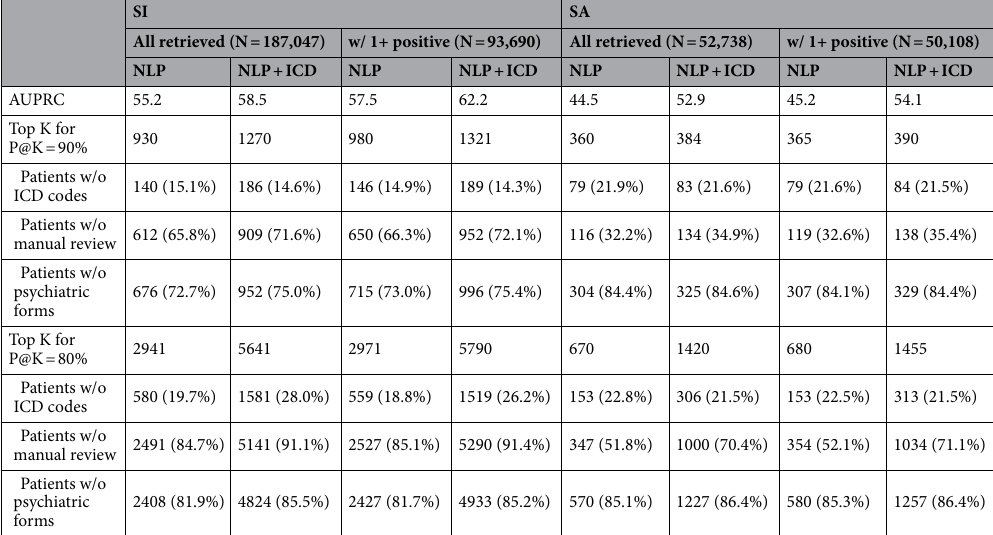
SI SA All retrieved (N = 187,047) w/ 1+ positive (N =